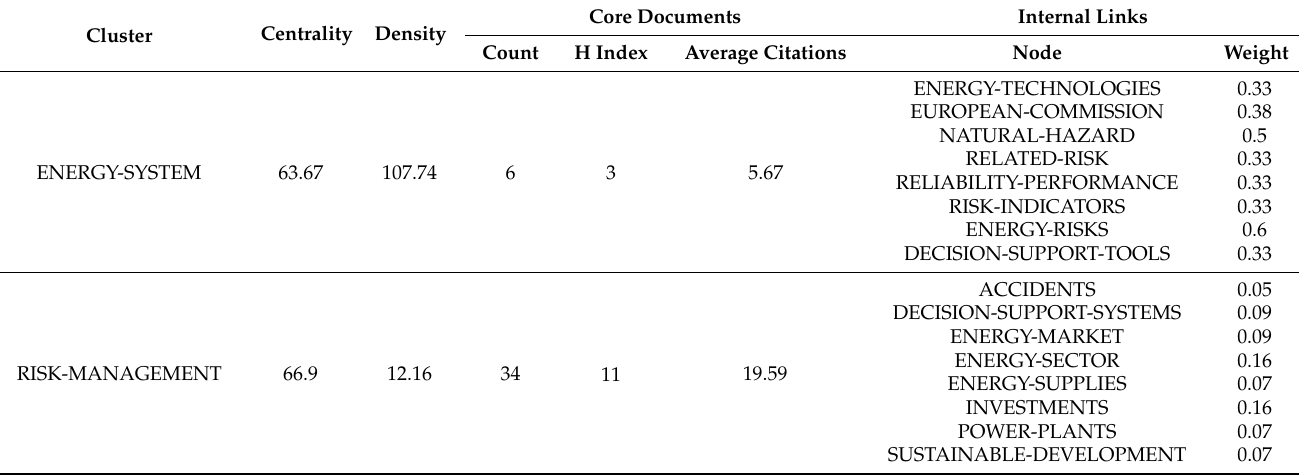
Table 5. Cluster information and key parameters—sub-period